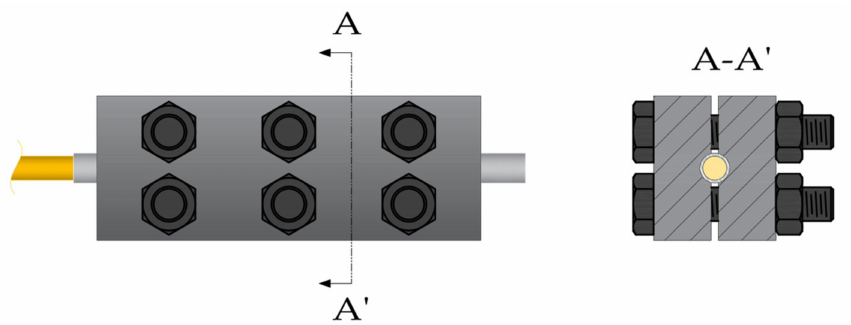
Figure 2. Example of a clamping anchorage composed of two steel plates joined by steel